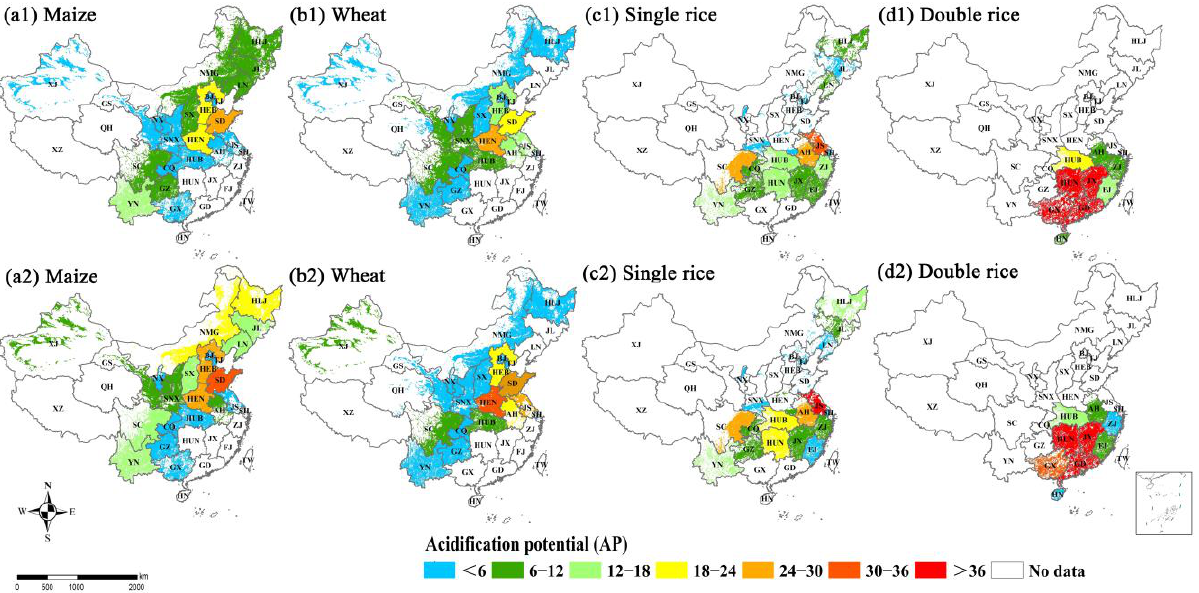
Figure 6. The acidification potential (AP) between 2004 – 2008 and 2014 – 2018 for ( a1 , a2 ) maize, ( b1 , b2 ) wheat, ( c1 , c2 ) single rice and ( d1 , d2 ) double rice at provincial scale in China’s farmlands, respectively.